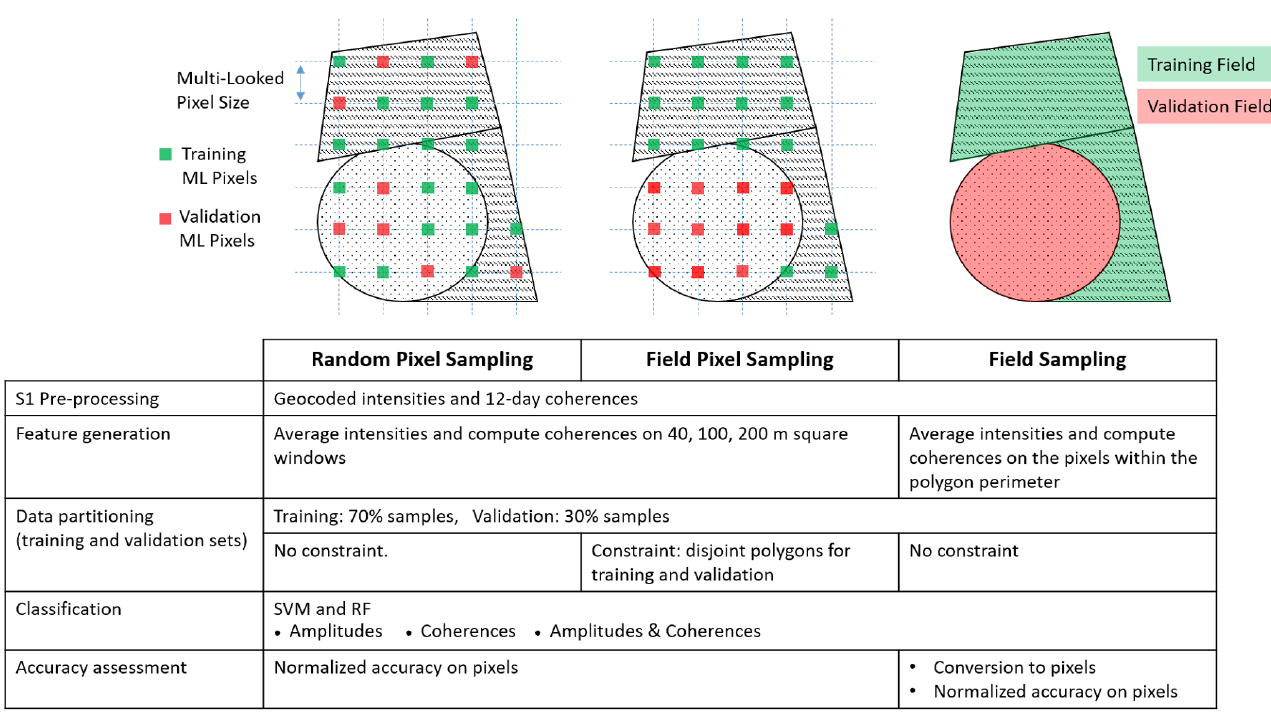
Figure 5. ( Top ) Sketched illustration of the pixel-based and field-based sampling schemes for three polygons belonging to the same class. The different patterns in the polygon background represent intra-class diversity; ( Bottom ) For each sampling scheme, the methodology steps from image pre-processing to accuracy evaluation are briefly